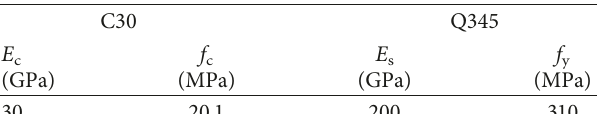
Table 1: Material